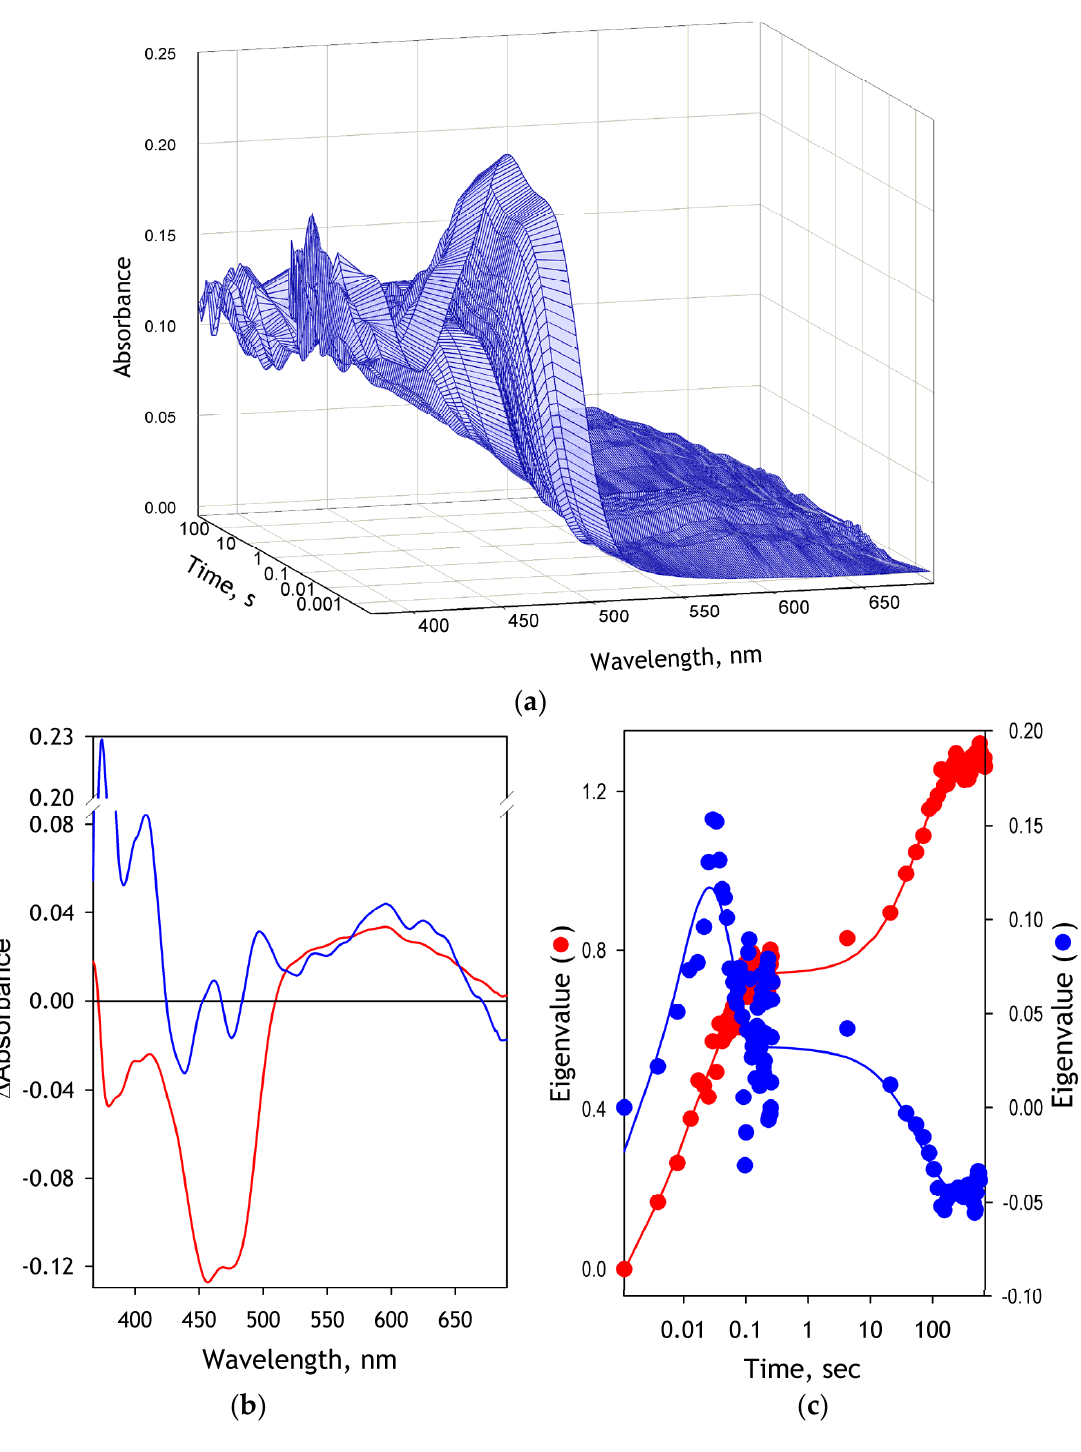
Figure 2. Changes in the spectra of absorbance of SbCPR in the process of its NADPH-dependent reduction. Panel ( a ) exemplifies a series of absorbance spectra recorded in a rapid-scanning stop-flow experiment. Panel ( b ) shows the spectra (eigenvectors) of the first (red) and second (blue) Principal Components obtained with PCA of the above dataset, and panel ( c ) represents the respective sets of eigenvalues plotted against time in semi-logarithmic coordinates. Solid lines in this panel correspond to the approximations of the kinetic curves with the three-exponential equation.